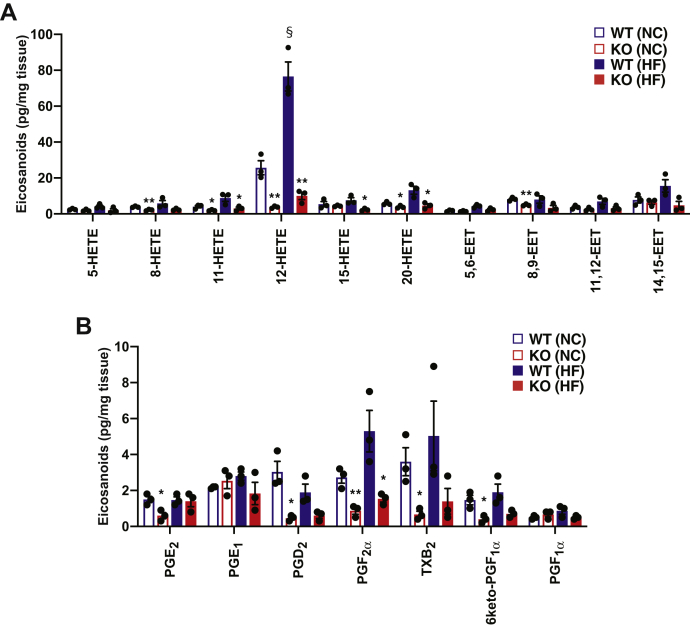
Eicosanoid profiles in wild-type and hepatocyte-specific iPLA2γKO liver tissue after normal-chow or high-fat feeding. Eicosanoids in wild-type (WT) and HEPiPLA2γKO (KO) mouse livers after normal-chow or high-fat feeding were extracted and derivatized with AMPP. Mass spectrometric analyses for the identification and quantification of eicosanoids including HETEs, EETs (A), and prostaglandins (B) were performed by LC-MS/MS via MRM in the positive-ion mode with accurate mass analysis of diagnostic product ions following separation of molecular species using a reverse phase column as described under Materials and Methods. ∗P < 0.05 and ∗∗P < 0.01 when compared with WT on the same diet. §P < 0.005 in comparisons of WT NC versus HF. EET, epoxyeicosatrienoic acid; HEPiPLA2γKO, hepatocyte-specific iPLA2γ-knockout; HETE, hydroxyeicosatetraenoic acid; HF, high-fat; MRM, multiple-reaction monitoring; NC, normal-chow; PG, prostaglandin; TXB2, thromboxane B2.